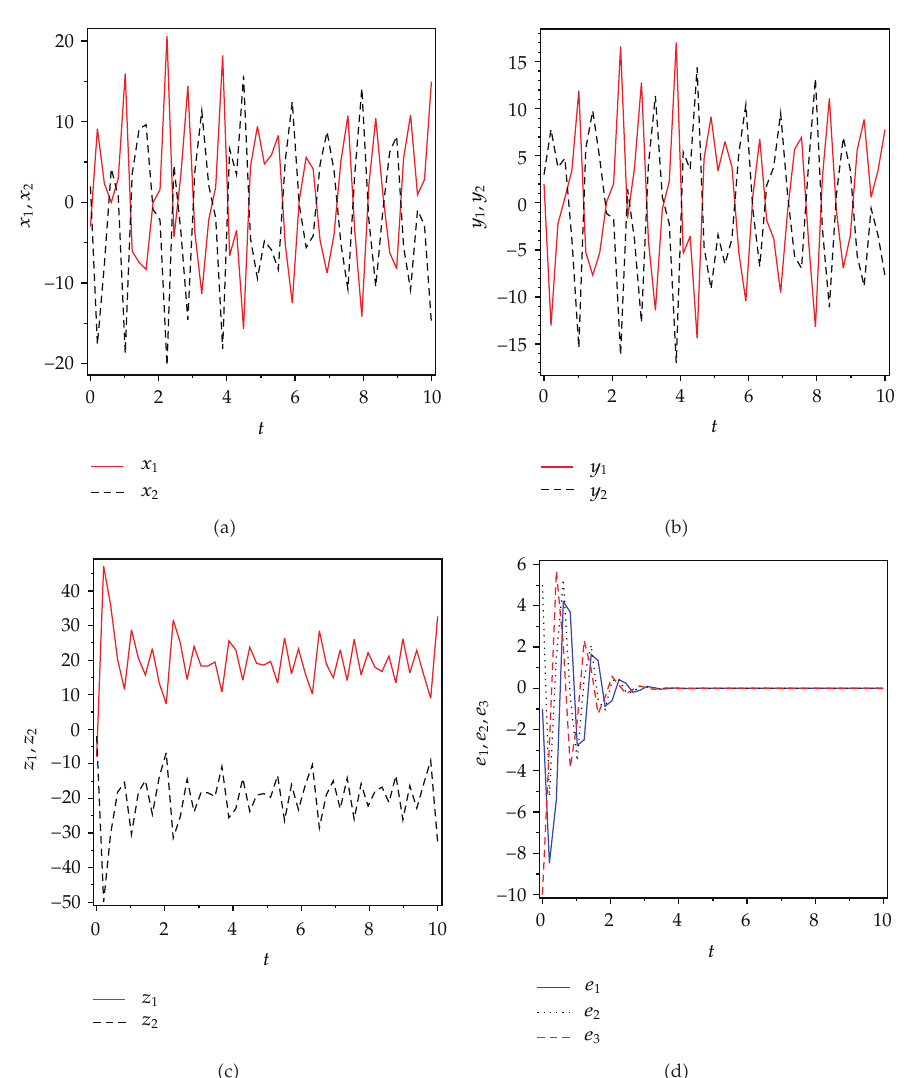
Figure 3: State trajectories of drive system (cid:7) 5.2 (cid:10) and response system (cid:7) 5.3 (cid:10) , (cid:7) a (cid:10) signals x 1 and x 2 ; (cid:7) b (cid:10) signals y y (cid:7) c (cid:10) signals z z (cid:7) d (cid:10) the error signals e 1 and 2 ; 1 and 2 ; system under the controller (cid:7) 5.8 (cid:10)